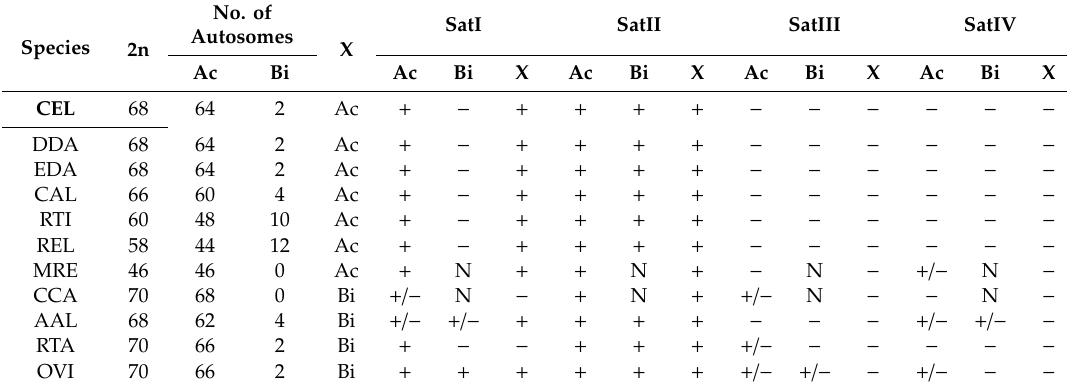
Table 4. Fluorescence in situ hybridisation (FISH) patterns of the satI-IV probes in the analysed cervid